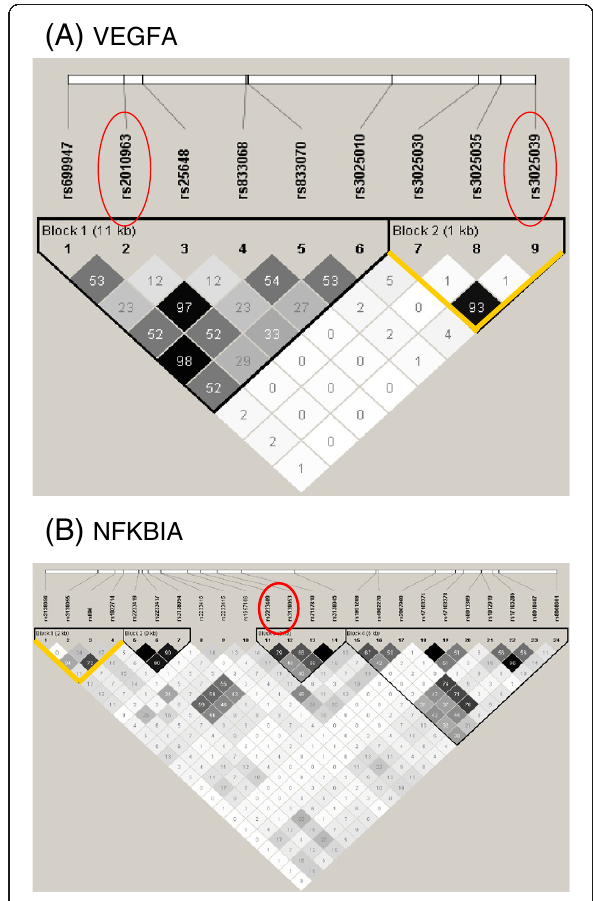
Figure 3 LD plots for European ancestry (AA) trauma subjects for 2 genes with positive ALI associations. Plots for the genes VEGFA ( A ) and NFKBIA ( B ) are shown. Grayscale reflects the pairwise LD as measured by r 2 , with high LD in black and low/absent LD in white. As in Figure 2, previously reported ALI – associated SNPs are circled (red) and the yellow lines outline the haplotypes detected by kernel function(s) as being associated with ALI. Whereas the block detected in VEGFA is defined by the previously reported SNP rs3025039, the association with NFKBIA does not overlap the previously reported NFKBIA ALI – associated